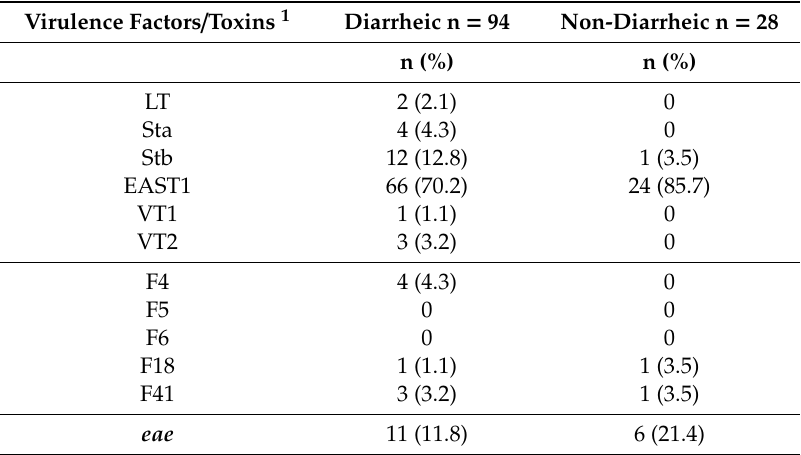
Table 2. Comparison of virulence factors and pathogenic E. coli prevalence in diarrheic (n = 94) and non-diarrheic (n = 28) pig groups.